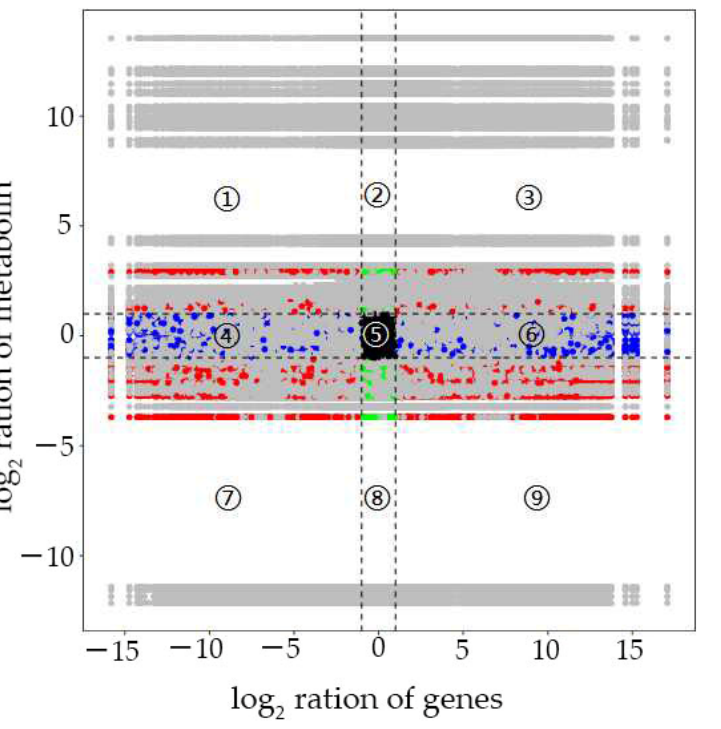
Figure 7. Quadrant diagrams representing the association of the DAMs and DEGs between Ce679 and R4233. The x -axis indicates the log 2 ratio of genes, and the y -axis the log 2 ratio of metabolites. Black dotted lines indicate the threshold. Each gene indicates a metabolite or gene. Black dots denote the unchanged genes or metabolites; green dots indicate DAMs with unchanged genes; blue dots represent DEGs with unchanged metabolites; DEGs and DAMs are shown by red dots, divided into 9 quadrants from top to bottom and left to right with black dotted lines. The quadrants ① , ② , and ④ indicate that the expression abundance of metabolites is higher than that of genes; the quadrants ③ and ⑦ indicate that the expression patterns of genes are consistent with the metabolites; the quadrant ⑤ indicates that the genes and metabolites are not differentially expressed; the quadrants ⑥ , ⑧ , and ⑨ denote that the expression abundance of metabolites is lower than that of genes.